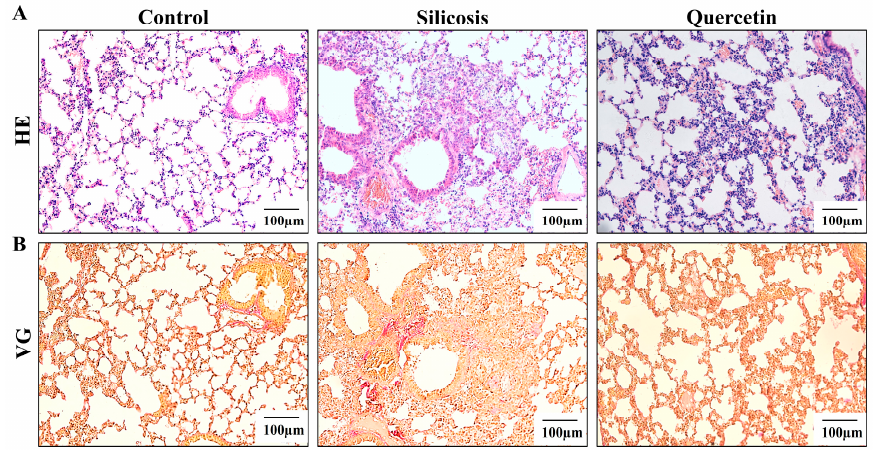
Figure 1. Quercetin inhibited the progression of silicosis in mice. ( A ) Hematoxylin–eosin staining of lung tissues (scale bar = 100 µm). ( B ) Van Gieson’s staining of lung tissues (scale bar = 100 µm).